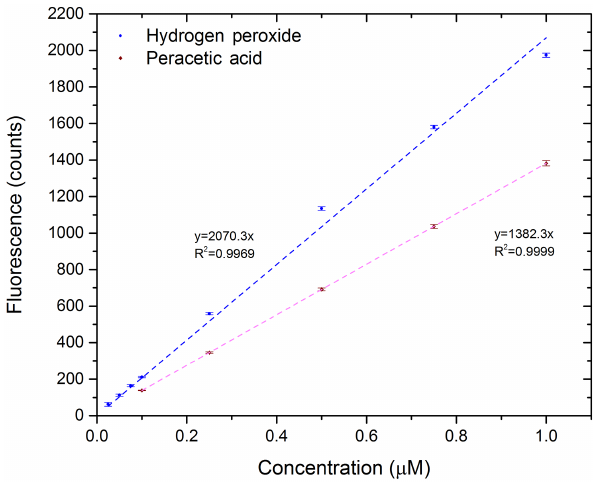
Figure 4. Example OPROSI calibration plot with standard ROS compound hydrogen peroxide and peroxide peracetic